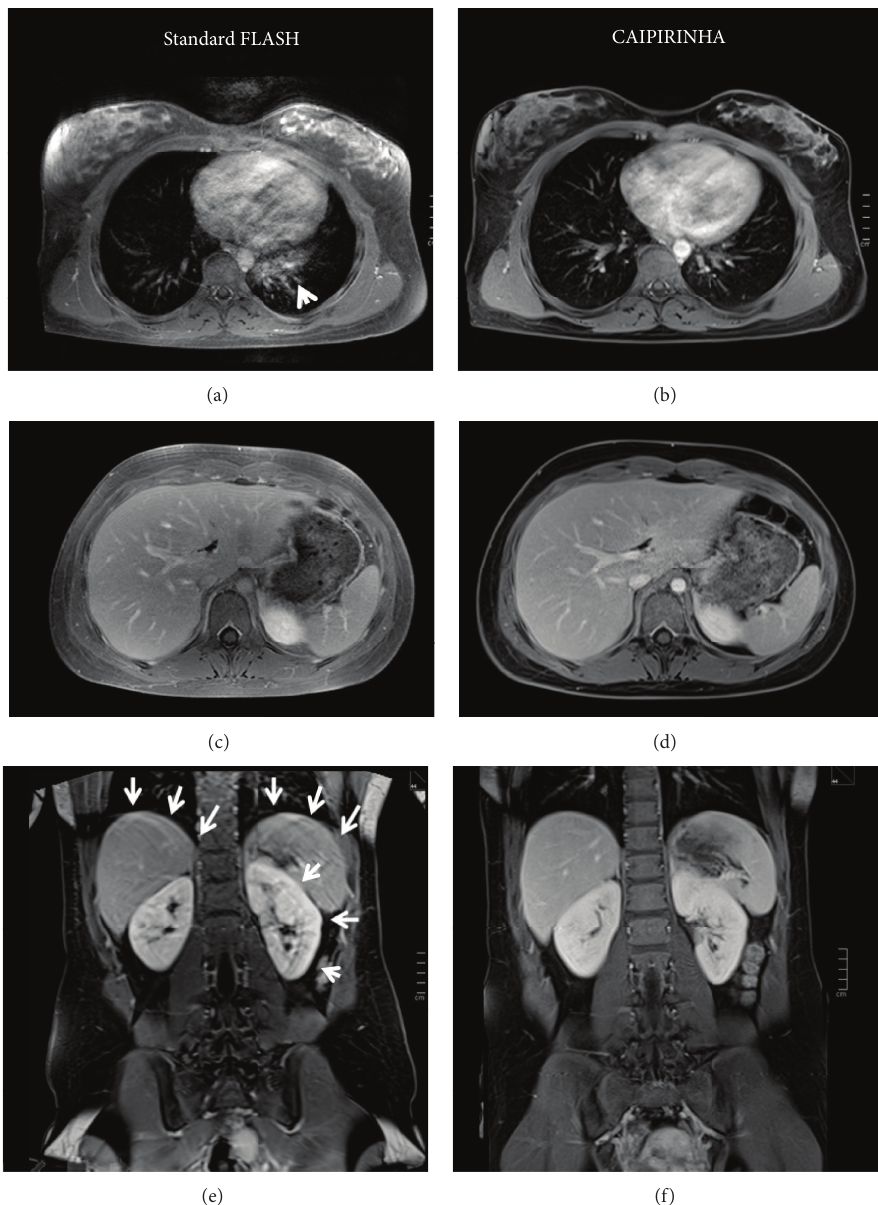
Figure 1: Thoracic and abdominal MRI study in a 17-year-old female patient with Hodgkin’s disease in complete remission. Images are displayed for contrast-enhanced fat-saturated standard FLASH (a, c, e) and CAIPIRINHA-accelerated T1w 3D FLASH (b, d, f) from the transversethoracicimagestack(a,b),thetransverseabdominalimagestack(c,d),andthecoronalabdominalimagestack(e,f).Thesequences were scanned in turns on the respective level as standard FLASH first, followed by CAIPIRINHA. With CAIPIRINHA, there are markedly less retrocardial artefacts ((b), as compared to standard FLASH (a), arrowhead). While the transverse thoracoabdominal scans otherwise show excellent image quality with both FLASH and CAIPIRINHA, the patient could eventually no longer fully comply with the frequent breath- holds, so that the coronal FLASH image (e, arrows) is degraded by respiratory motion artefacts and shows blurring of contours along the diaphragm and the kidneys. The final acquisition of the coronal CAIPIRINHA sequence (f) again is virtually free of artefacts. The transverse abdominal scans were included in the study analysis and were consistently graded as IQ = 5 by both